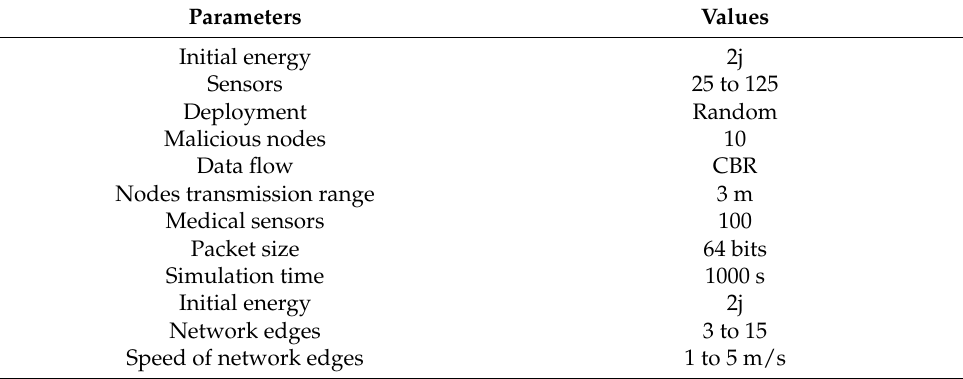
Table 2. Simulation